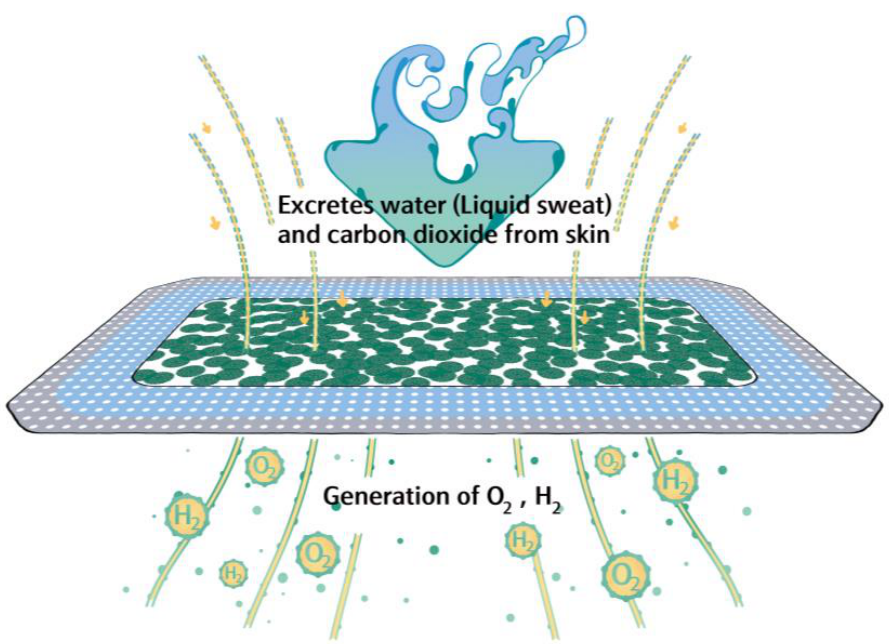
Figure 2. Schematic illustration of the mechanisms of hydrogen/oxygen-generating patch. Mech- anisms of H + /O 2 − producing formulas; peroxide reacts with water to from hydroxides, and then release oxygen.